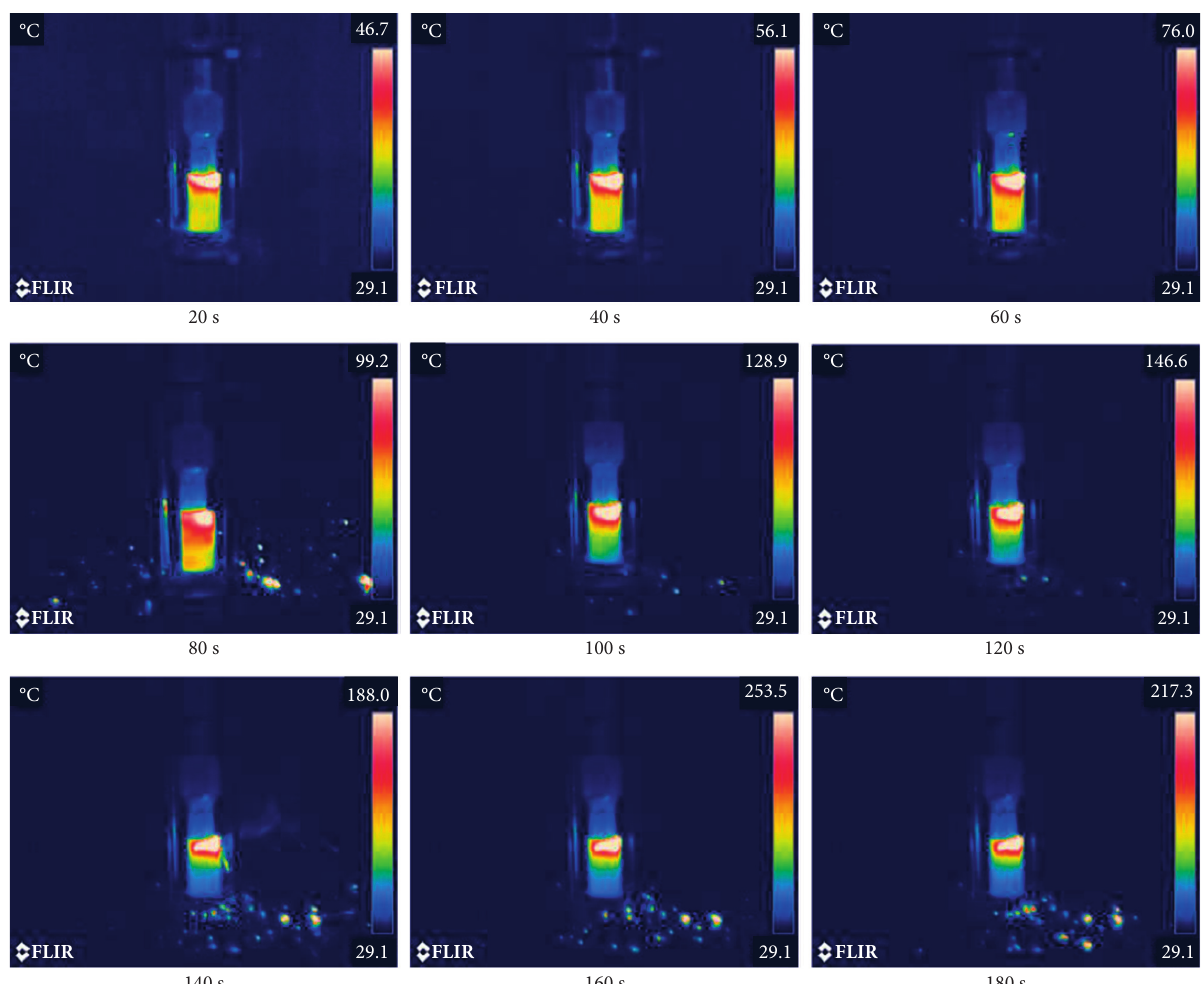
Figure 7: Spatiotemporal evolution map of rock surface temperature field